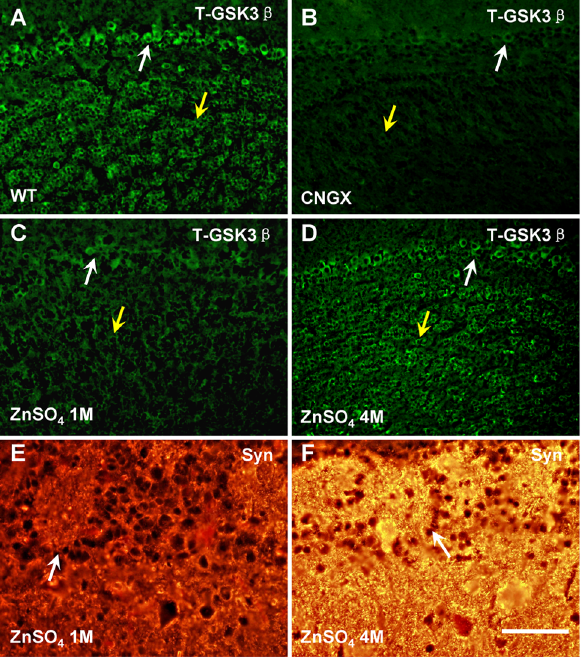
Figure 1. Olfactory deficit reduced the expression level of GSK3 b in the OB. A: T-GSK3 b was widely expressed in the mouse OB, including the mitral cells and granule cells. B: The T-GSK3 b signal was significantly decreased in the OBs of CNGX mice. C: The T-GSK3 b signal was decreased one month after ZnSO 4 irrigation. D: The T-GSK3 b expression level in OB was partially recovered four months after ZnSO 4 irrigation. (A–D: white arrow, mitral cell layer; yellow arrow, granular cell layer). E & F: Compared to the signal at one month following ZnSO 4 irrigation, Syn in the OB was stronger at four months post-treatment (E– F: white arrow, glomerulus). Syn: synaptophysin; Scale bar, A–D, 100 m m; E–F, 50 m m.